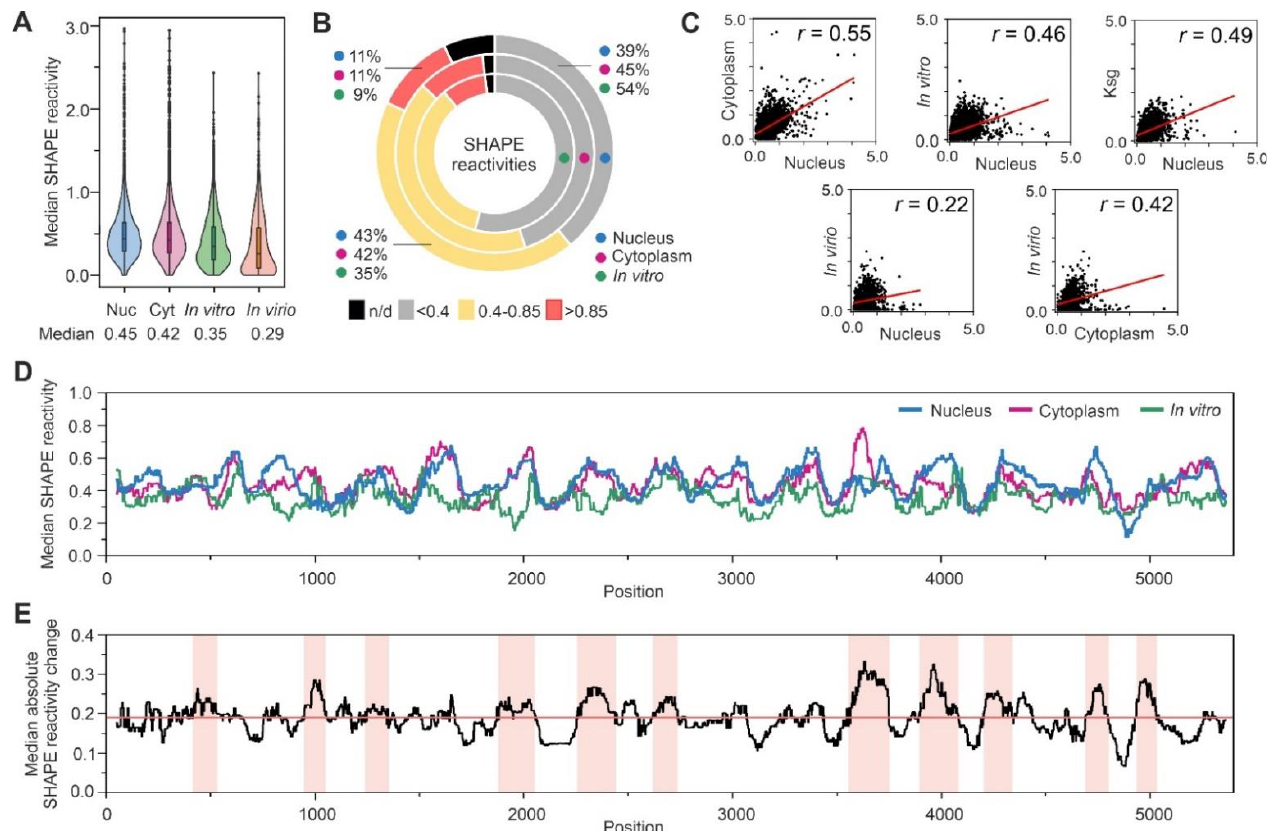
Figure 2. Analysis of SHAPE reactivities for nuclear Ty1 gRNA compared to cytoplasmic and in vitro full-length Ty1 gRNAs, the inhibition of translation initiation state (for 2500 nts), and the in virio state (for 1482 nts). ( A ) Violin plot analysis of SHAPE reactivity distributions with medians. ( B ) Pie chart analysis of SHAPE reactivity percentage distribution. ( C ) Correlation of position-dependent NMIA reactivities. ( D ) The median SHAPE reactivity profiles smoothed within a 75-nt window. ( E ) The median profile of absolute SHAPE reactivity change between nuclear and cytoplasmic datasets, smoothed within a 75-nt window. Light-red shadings indicate regions with the greatest absolute differences above the global median change (marked in red) (see Section 2).